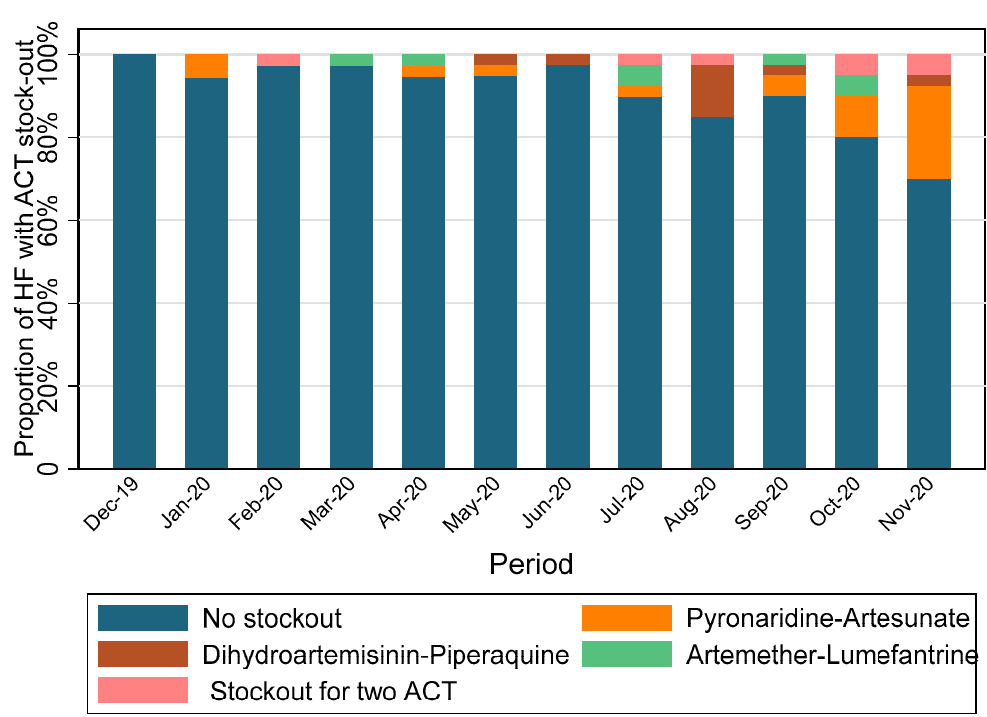
Figure 3. Study drugs stock management.